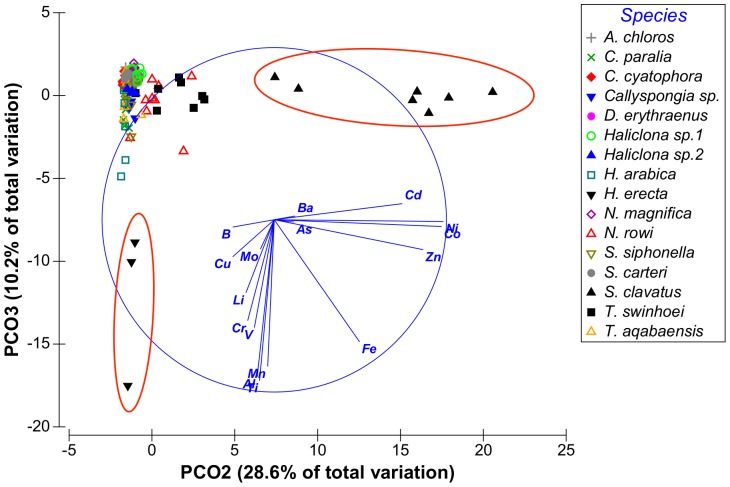
Distribution of sponge samples along PCOI vectors 2 and 3.Species of interest are circled in red.